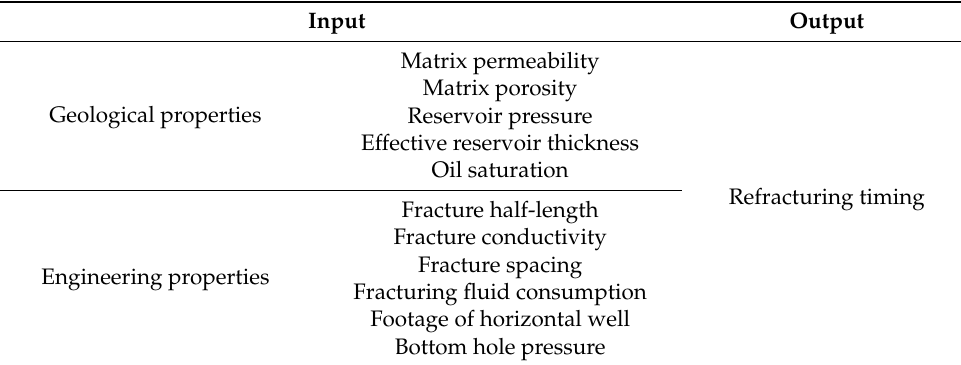
Table 1. Prediction input and output of the